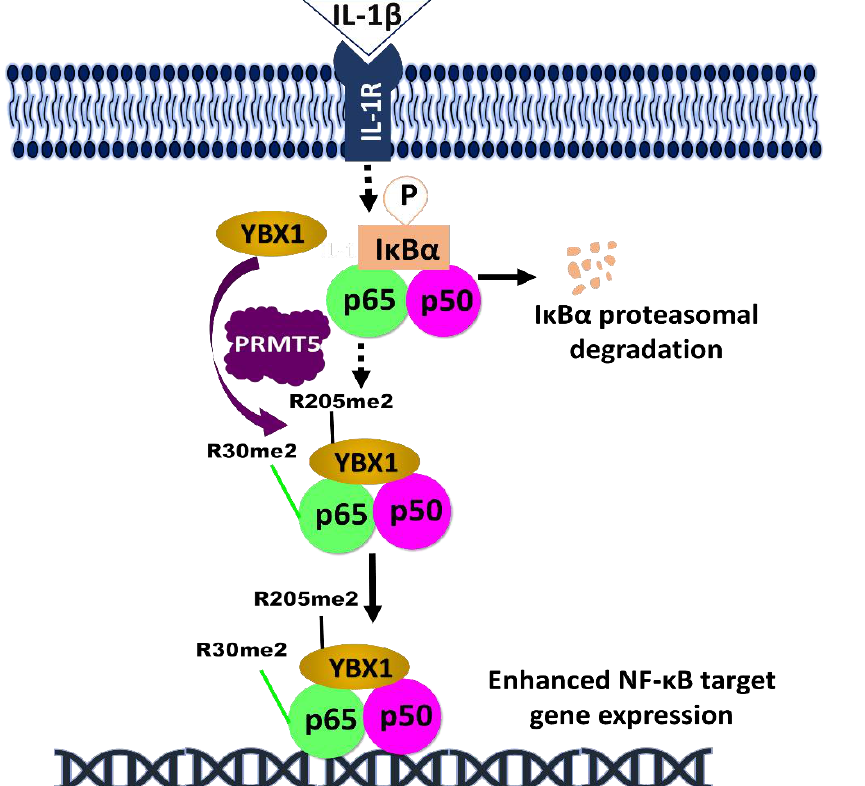
Figure 2. Hypothetical model of the complex regulation of NF- κ B by YBX1 and PRMT5. Following the induction of NF- κ B by IL-1 β treatment, IKK β is activated and phosphorylates I κ B α , leading to its proteasomal degradation. This promotes the nuclear translocation of NF- κ B dimers. Simultaneously, PRMT5 dimethylate YBX1 at R205 [72], and p65 at R30 [49]. On one hand, the R205me2 modification may enhance the interaction between p65 and YBX1, thereby YBX1-mediated activation of p65. On the other hand, p65-R30me2 augments the NF- κ B activity and together with YBX1, to enhance the overall DNA binding capability of p65 and further promote cancer progression.